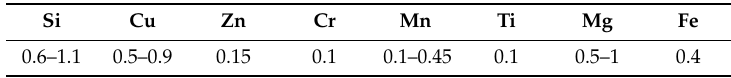
Table 2. The chemical composition of AA6111-T4 aluminum alloy [% weight].